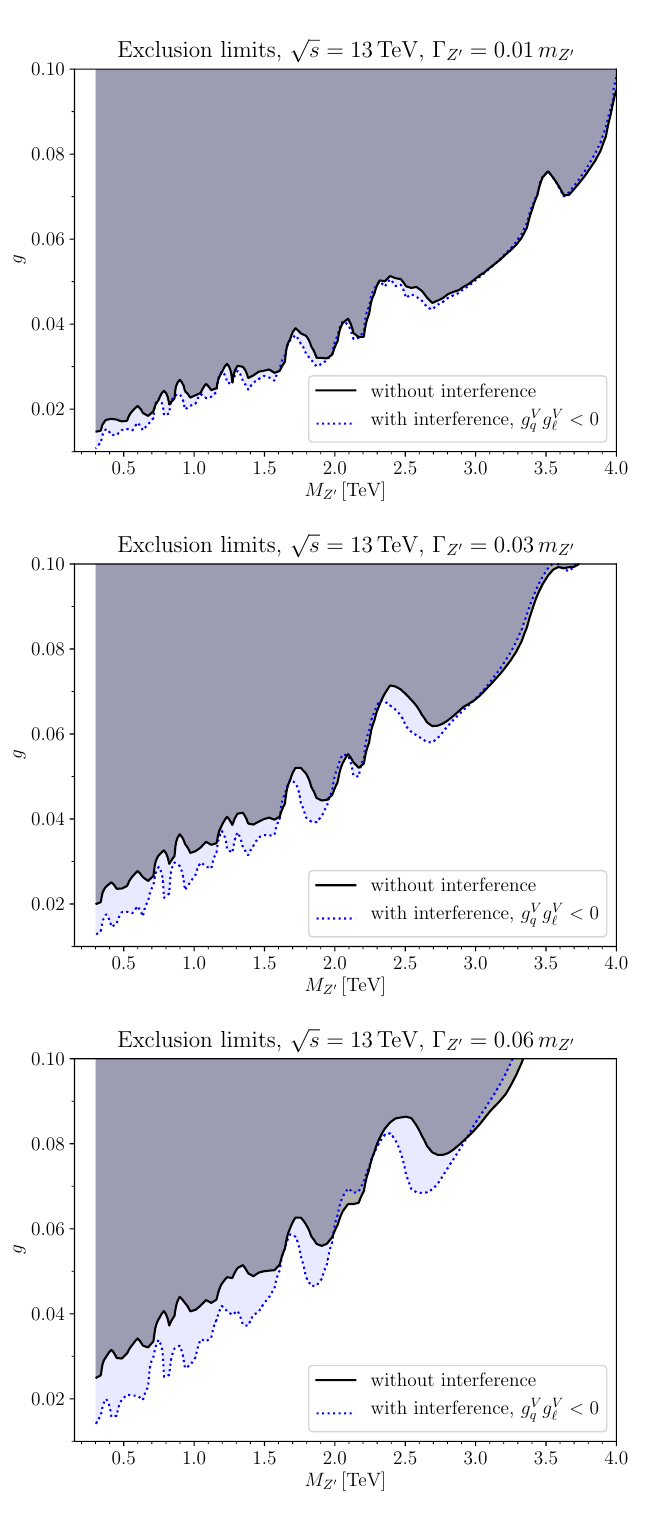
Figure 7 . Same as (cid:12)gure 4 but for the case that g V